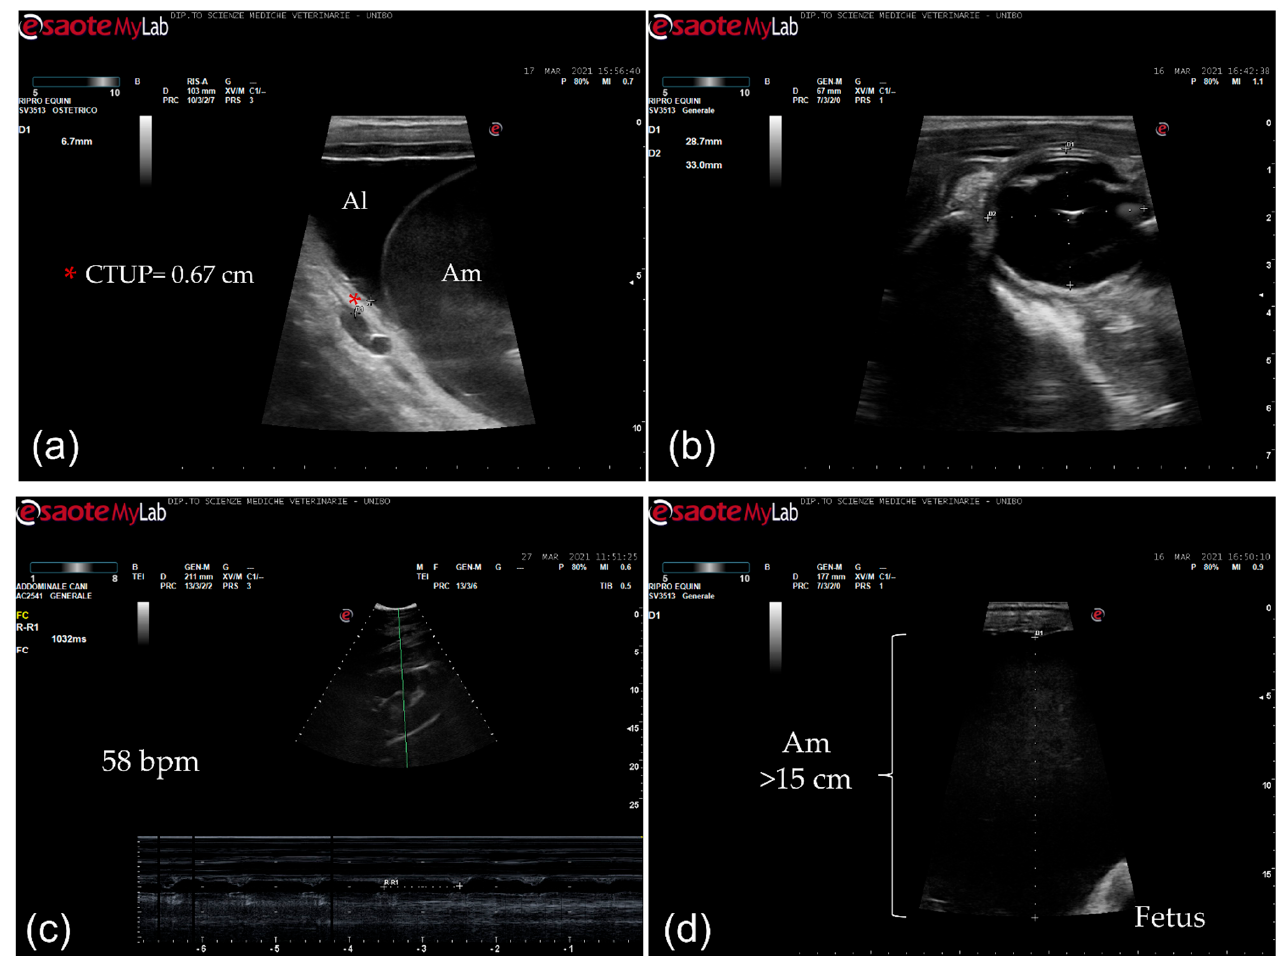
Figure 1. Ultrasonographic images. ( a ) Transrectal ultrasonographic examination of the combined thickness of the uterus and placenta (CTUP) (red asterisk); Al: allantoic fluid; Am: amniotic fluid; ( b ) fetal orbit measurement (transrectal ultrasonography); ( c ) fetal heart rate measurement (58 bpm) (transabdominal ultrasonography); ( d ) depth of the amniotic fluid (>15 cm) (transabdominal ultrasonography); Am: amniotic fluid.